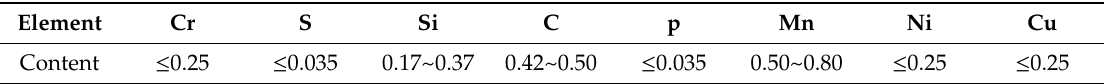
Table 1. Chemical composition of the #45 steel (mass fraction %).